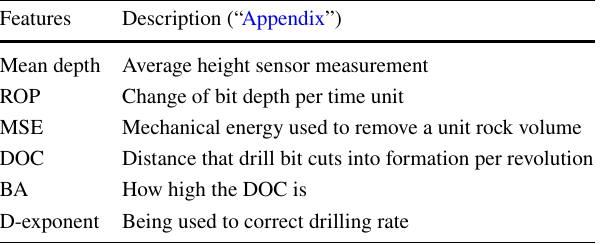
Table 5 Engineering features, where MSE is mechanical specific energy; DOC is depth of cut and BA is bit aggressiveness Features